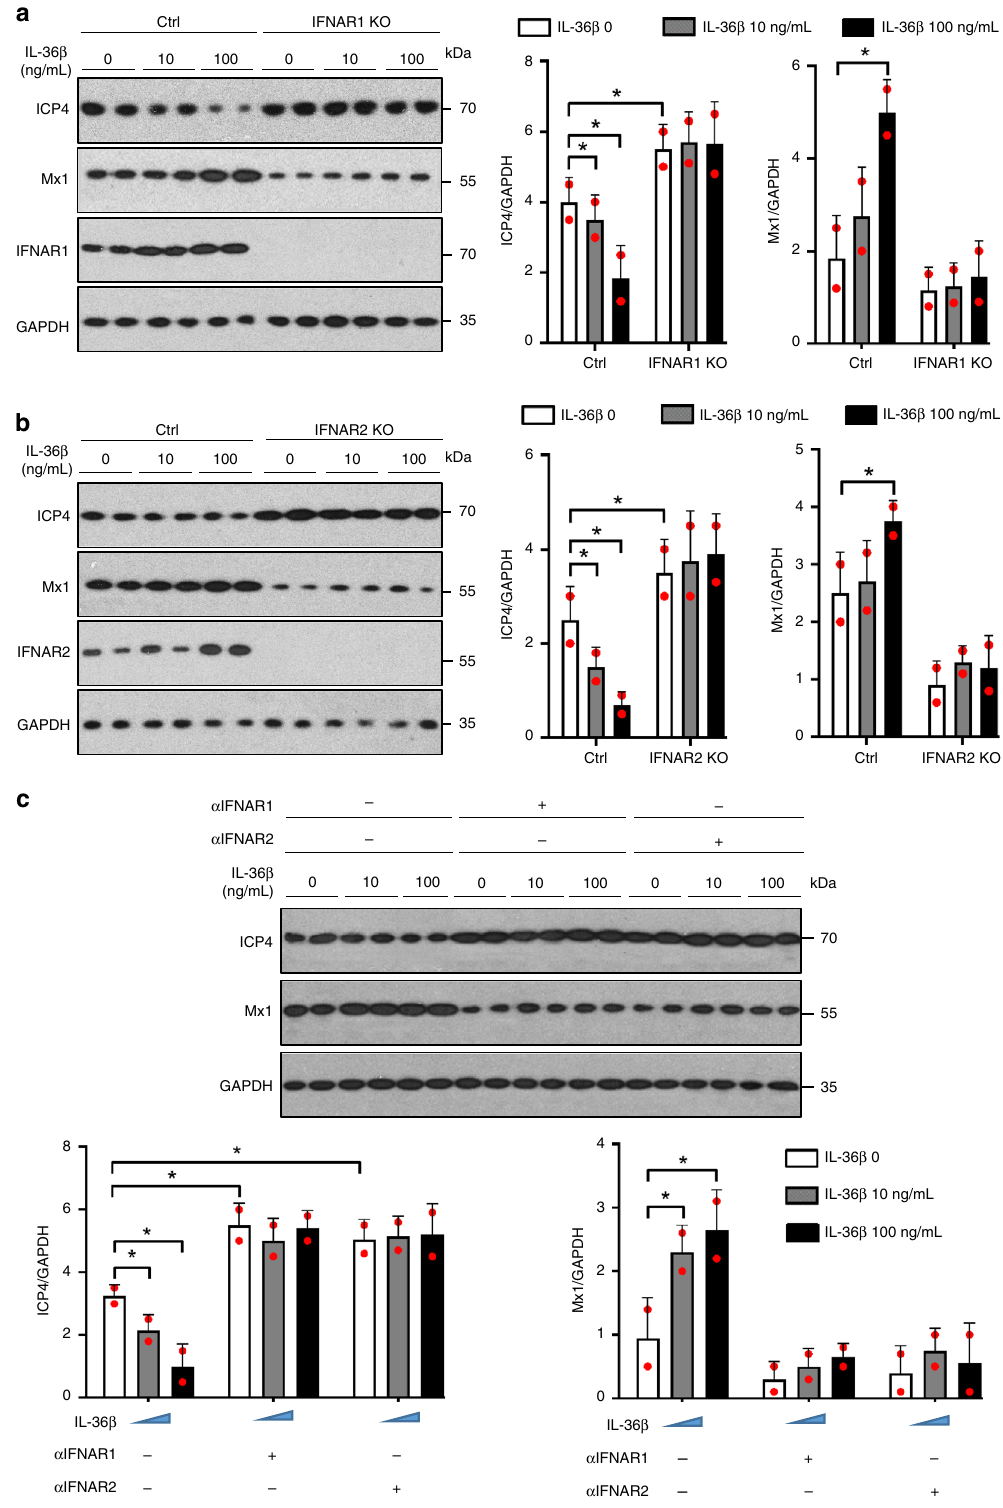
Fig. 8 IL-36 β induced antiviral state is dependent upon IFNAR. a Human keratinocytes were transfected with control (Ctrl) or IFNAR1 gRNA/Cas9 expression plasmids, treated with IL-36 β and infected with HSV-1. b Control (Ctrl) or IFNAR2 gRNA/Cas9 expression plasmid transfected human keratinocytes were treated with IL-36 β and infected with HSV-1. a , b Levels of ICP4, Mx1, IFNAR1, IFNAR2, and GAPDH were determined using western blotting and ImageJ analyses. c Mouse primary keratinocytes were treated with IL-36 β as indicated, incubated with neutralizing antibodies against IFNAR or isotype matched Ig and infected with HSV-1. Levels of ICP4, Mx1 and GAPDH were determined using western blotting and ImageJ analyses. a – c Quantitative data are shown as means ± SD. * p < 0.05 (one-way ANOVA, n = 2 biologically independent samples per treatment group). Each red dot represents a single data point. Source data are provided as a Source Data fi